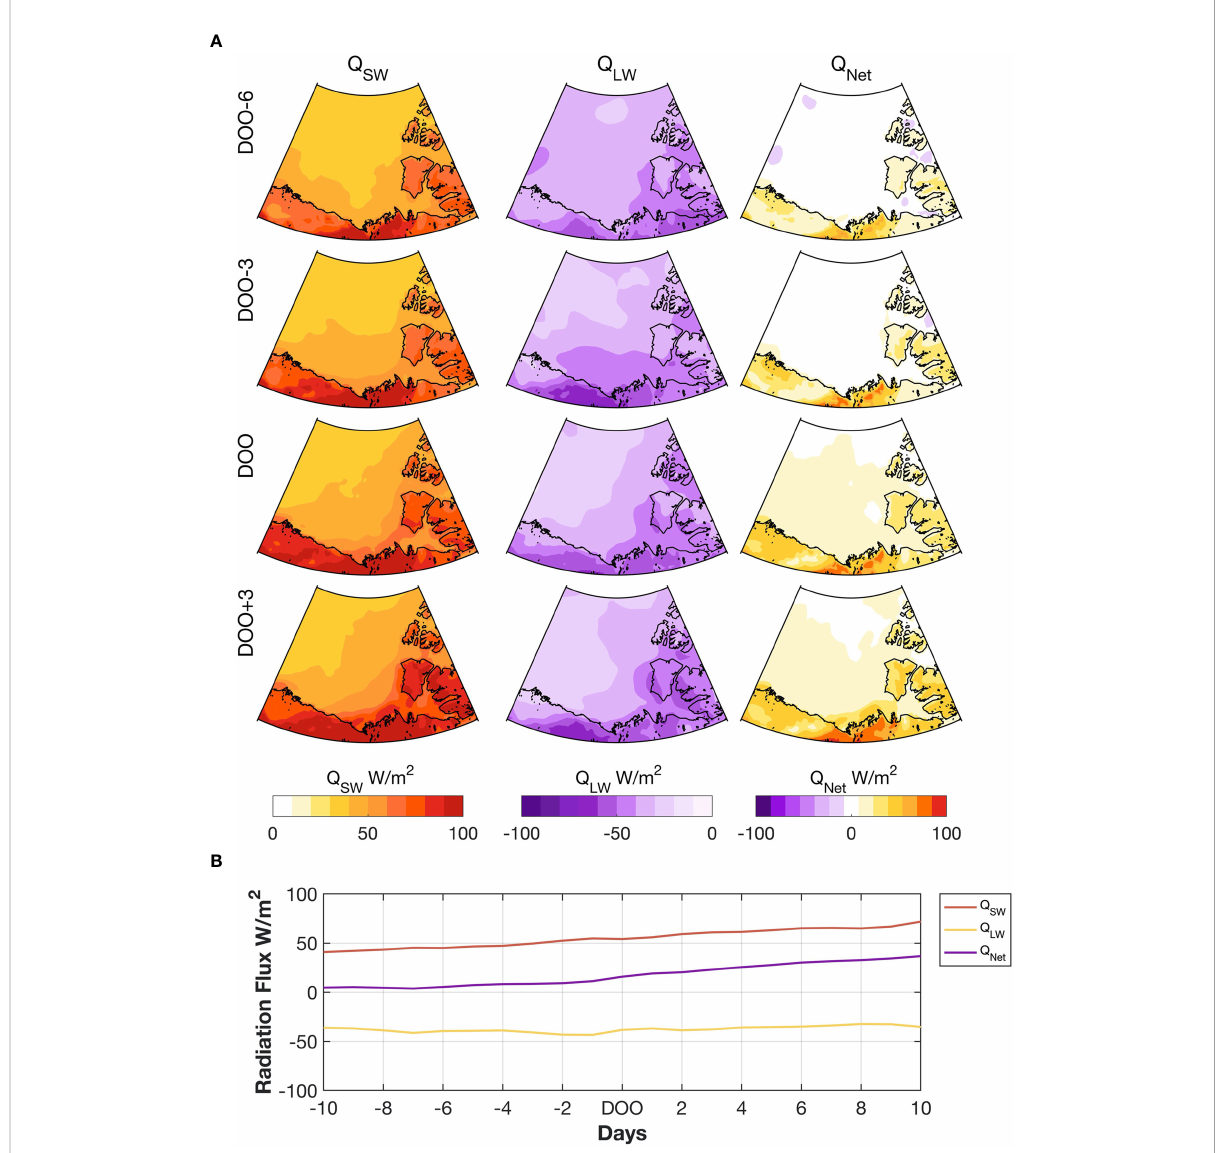
FIGURE 7 (A) Composite surface net shortwave radiation fl ux Q SW (the left column), surface net longwave radiation fl ux Q LW (the middle column), and surface net radiation fl ux Q Net (the right column) on DOO-6, DOO-3, DOO, and DOO+3 for the 2000 – 2019 period. Q Ne t = Q SW + Q LW . The units of all are W m − 2 , and positive (negative) values indicate a downward (upward) fl ux. (B) Composite time series of Q SW , Q LW , and Q Net averaged over the region outlined in Figure 1A (the land area is masked